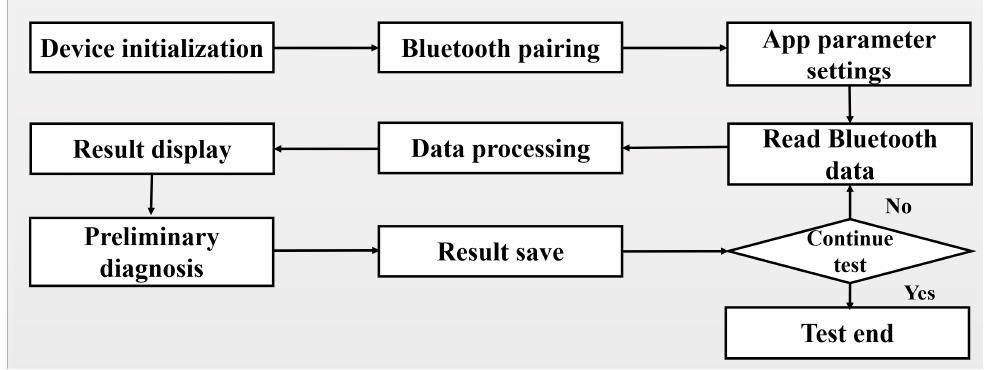
Figure 5. The flowchart of the spirometry app.